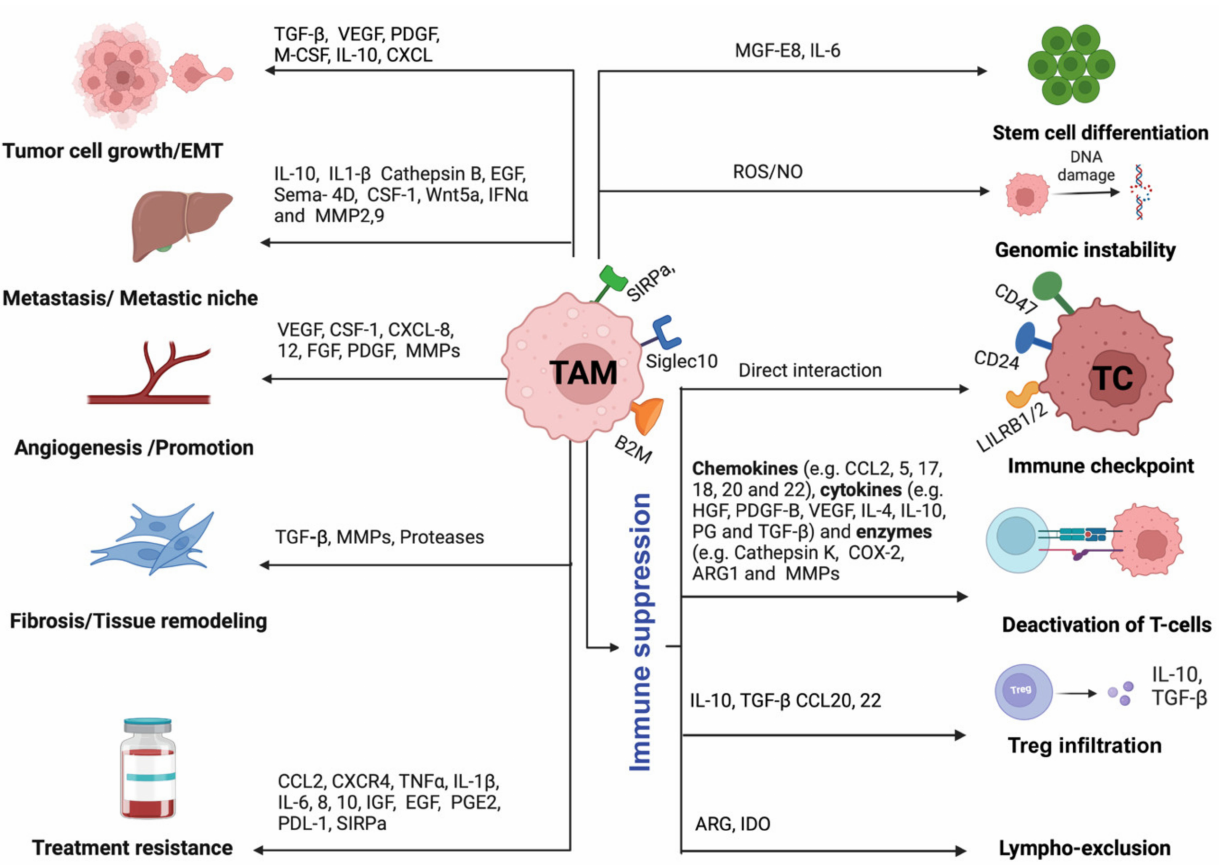
Figure 2. Illustration showing the role of tumor-associated macrophages in tumor progression through various mechanisms such as tumor growth/EMT, metastatic niche formation, initiation and promotion of angiogenesis, tumor tissue remodeling and fibrosis, treatment resistance, stem cell differentiation, genomic instability, and immune suppression. Abbreviations: ARG1, Arginine 1; TAM, tumor-associated macrophages; TC, tumor cell; B2M, beta-2-microglobulin; CCL, C-C chemokine ligand; COX-2, cyclooxygenase-2; CSF-1, colony-stimulating factor-1; CXCL, CXC chemokine ligand; CXCR, CXC chemokine receptor; EGF, epidermal growth factor; FGF, fibroblast growth factor; HGF, hepatocyte growth factor; IDO, indoleamine 2,3-dioxygenase; IFN, interferon; IGF, insulin-like growth factor; IL, interleukin; LILRB1/2, leukocyte immunoglobulin-like receptor subfamily B member 1/2; MFGE8, milk fat globule EGF and factor V/VIII domain containing; MMP, matrix metalloproteinase; M-CSF, Macrophage colony-stimulating factor; NO, nitric oxide; PDGF, platelet-derived growth factor; PDL1, programmed death ligand 1; PGE2, prostaglandin E2; ROS, reactive oxygen species; SEMA4D, semaphorin 4D; SIRP α , signal regulatory protein alpha; TGF- β , transforming growth factor- β ; TNF, tumor necrosis factor; VEGF, vascular endothelial growth factor (Figure created with BioRender.com accessed on 15 December